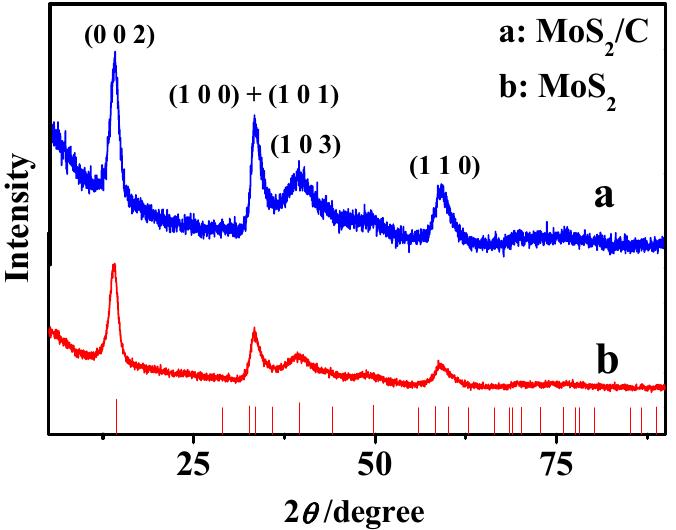
Figure 1. XRD patterns of the MoS 2 /C, MoS 2 , and the standard spectrum of MoS 2 (JCPDS No. 01-1201).